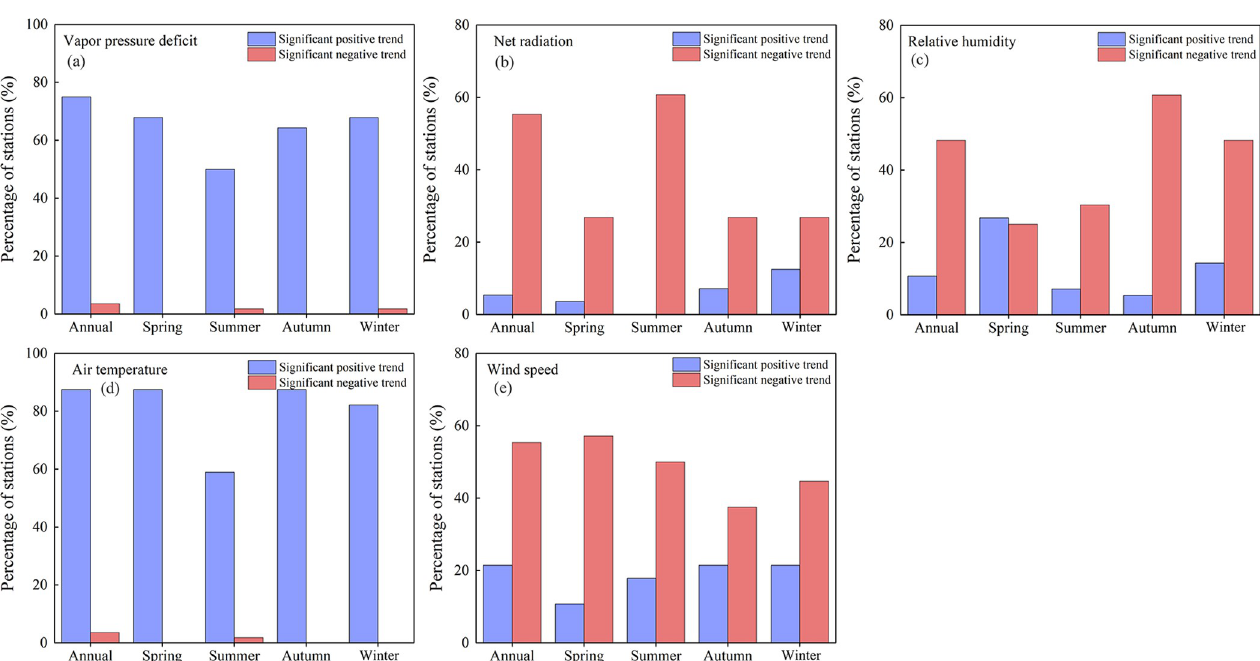
Fig 7. Percentage of stations with significant trends ( p < 0.05) for five basic meteorological variables ((a) vapor pressure deficit, (b) net radiation, (c) relative humidity, (d) air temperature and (e) wind speed) at annual and seasonal scales.